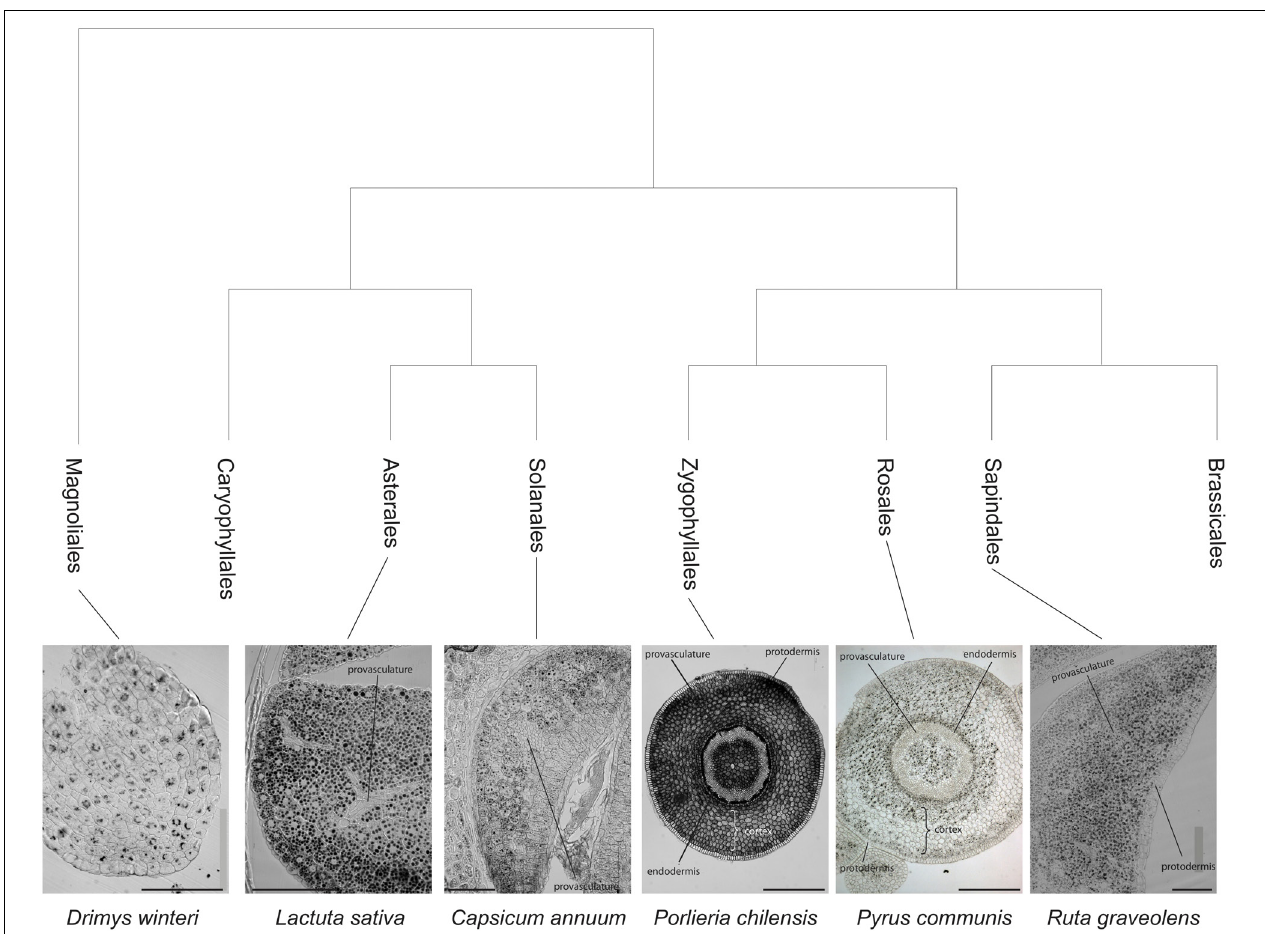
FIGURE 2 | Iron distribution in Eudicotyledoneae mature embryos. Iron distribution was revealed by Perls/DAB staining of hypocotyls ( Porlieria chilensis and Pyrus communis ) or cotyledons sections ( Ruta graveolens , Capsicum annuum , and Lactuca sativa ). The phylogenetic tree was assembled from The Angiosperm Phylogeny Group et al. (2016). Bars in panels correspond to 100 µ